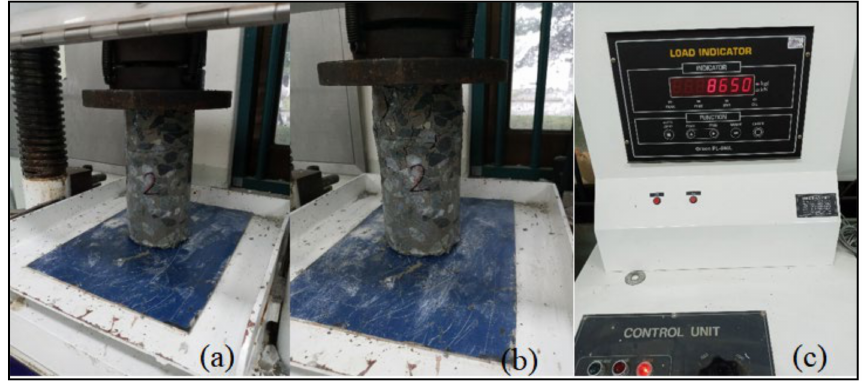
Figure 12. ( a ) Sample under compression, ( b ) failed sample, and ( c ) load